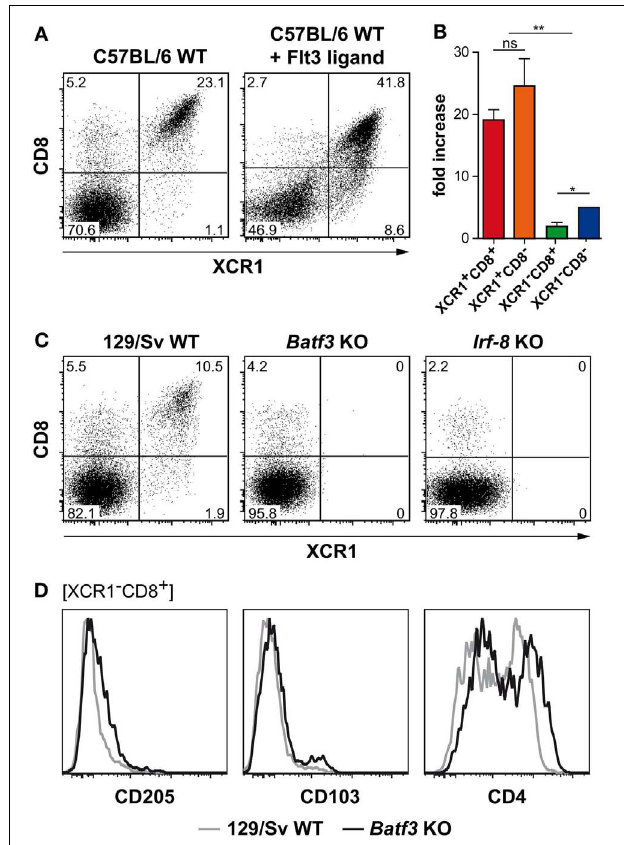
FIGURE 4 | Development of splenic XCR1 + DCs is dependent on the growth factor Flt3 ligand and the transcription factors Batf3 and IRF-8. (A,B) C57BL/6 mice were exposed to Flt3 ligand for 9days in vivo . Thereafter, spleens were removed, and the expression of CD8 and XCR1 on splenic cDCs (CD11c + MHCII + Lin − cells) was compared to unexposed controls. (A) Shown is one representative experiment out of four. (B) Fold increase (based on frequencies of live) of the indicated cDC subsets in relation to unexposed controls (mean ± SEM; n = 4; * p < 0.05; ** p < 0.01). (C) Splenocytes of 129/SvWT controls, Batf3 -deficient, or Irf-8 -deficient mice were stained with mAbs directed to CD8 and XCR1; shown is the expression of both markers on cDCs (CD11c + MHCII + Lin − cells). (D) Splenocytes of 129/SvWT controls (gray lines), or Batf3 -deficient mice (black lines) were stained for CD205, CD103, and CD4; shown are the expression profiles after gating on XCR1 − CD8 + cDCs. Data are representative of two